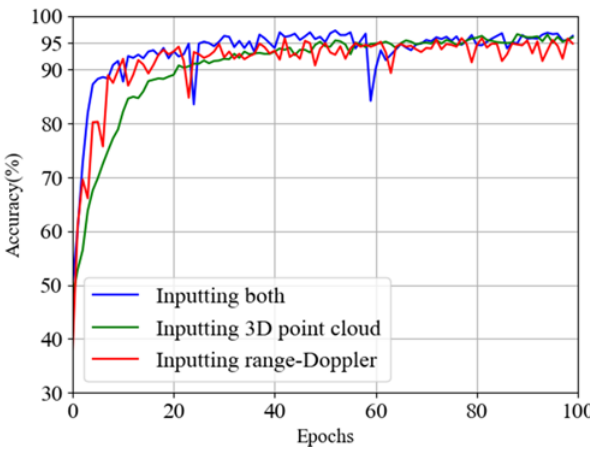
Figure 16. Accuracy curves of three different networks. Table 4. Accuracy and loss of the three networks using different kinds of